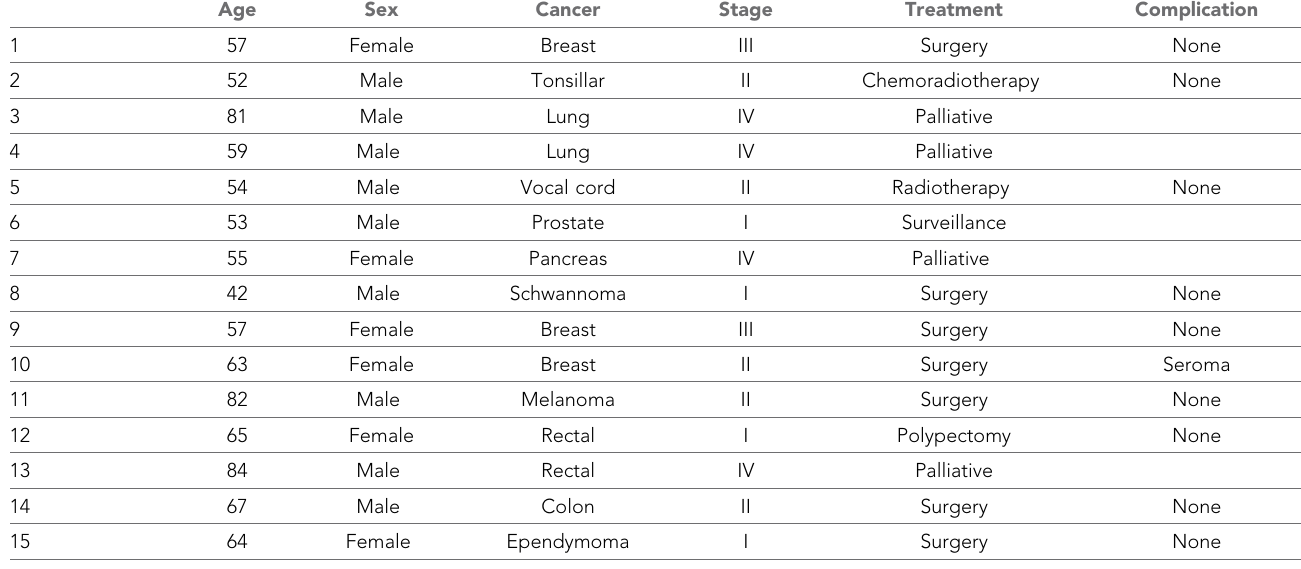
Table 1. Details of patients diagnosed with cancer Patient code